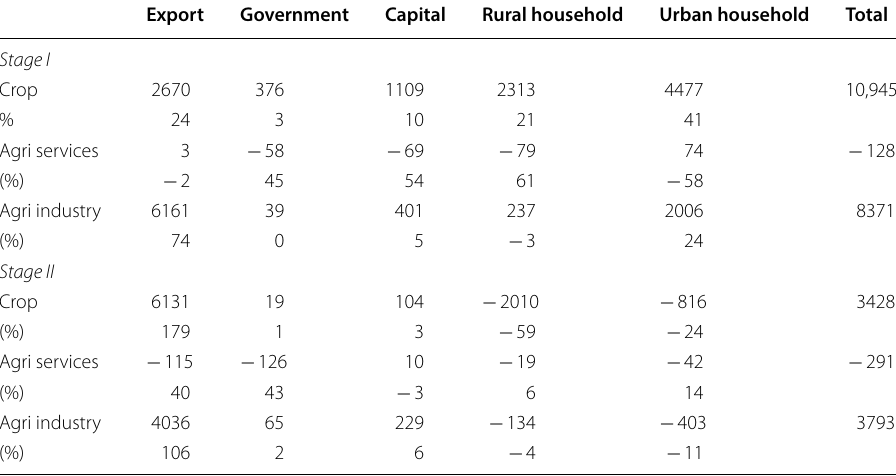
Unit : million Chinese